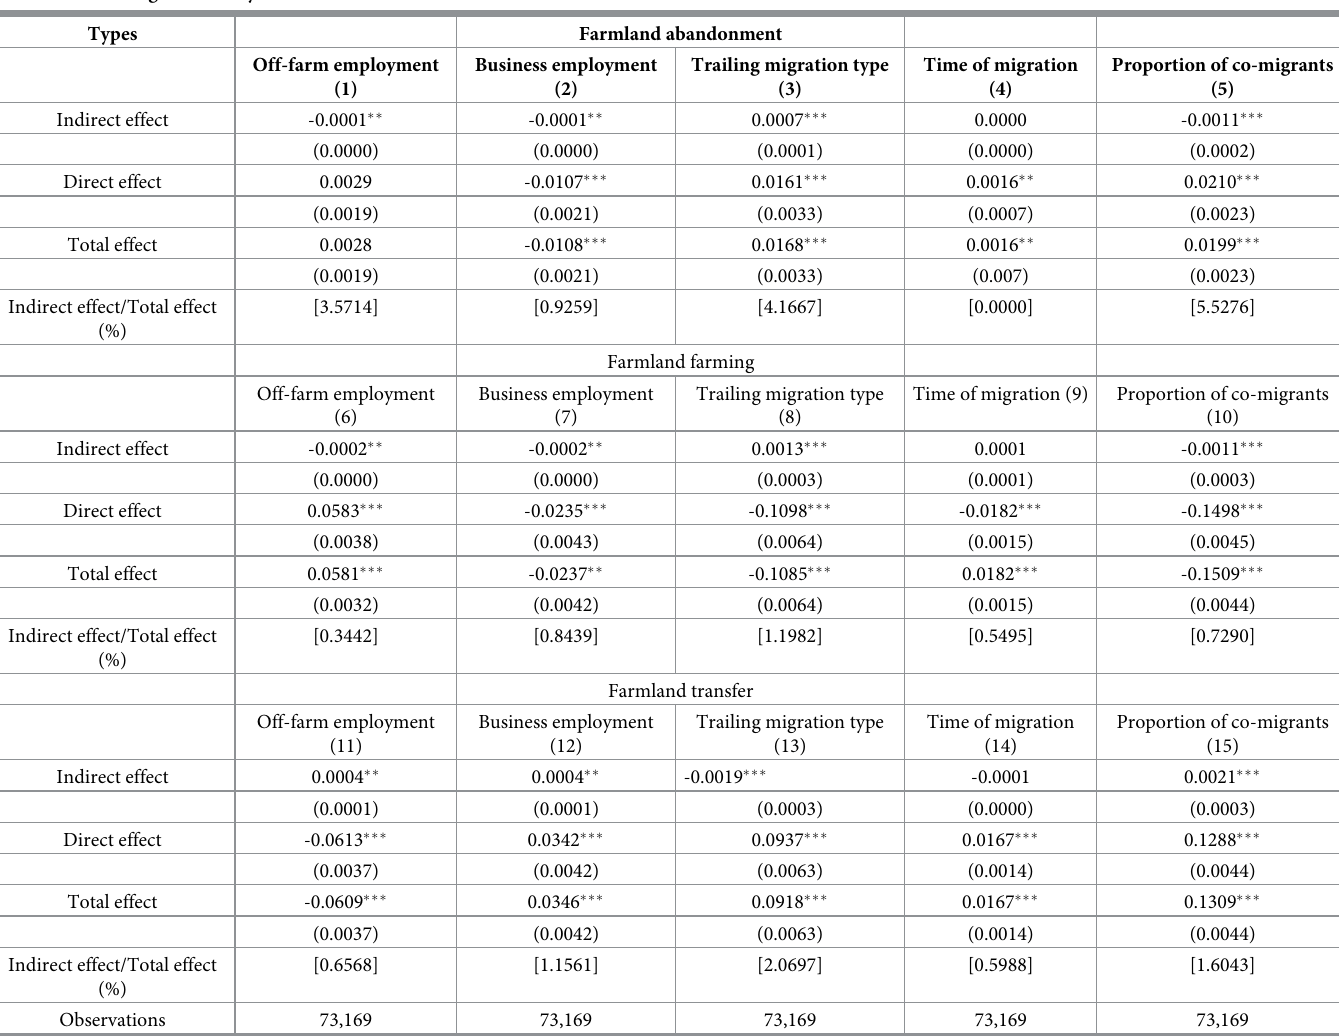
Table 8. Mediating effect analysis results–Sobel-Goodman